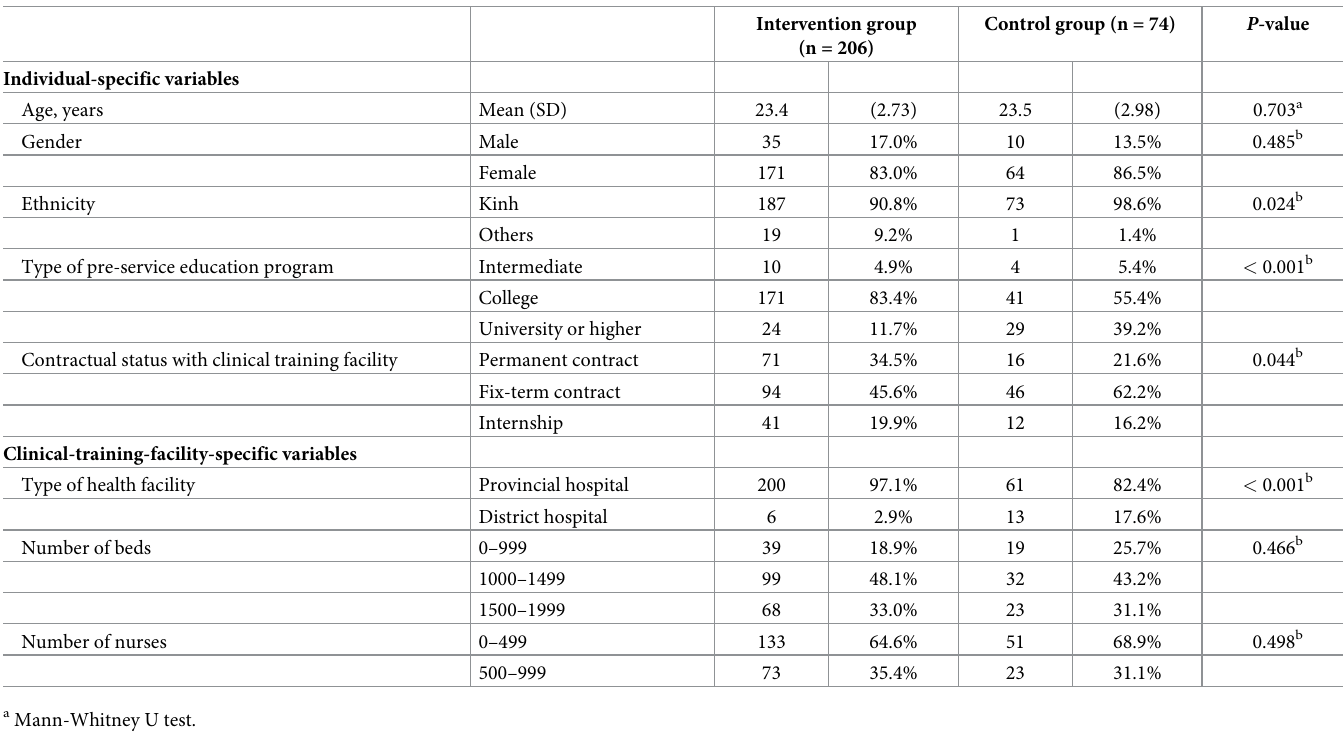
Table 3. Characteristics of study